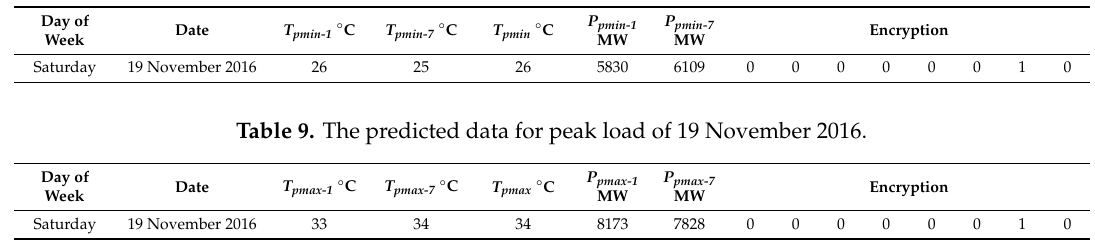
Table 8. The predicted data for valley load of 19 November 2016.